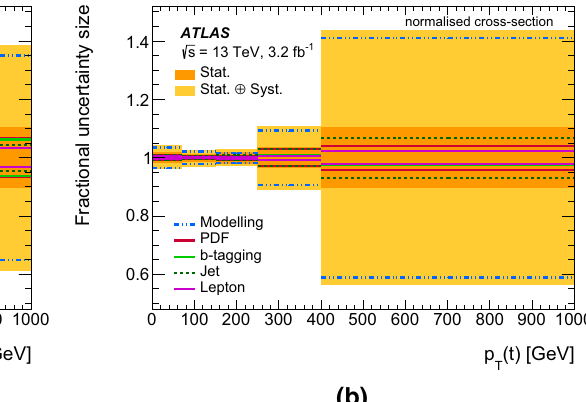
dashed lines . Systematic uncertainties from common sources, such as modelling of the t ¯ t production, have been grouped together. Uncertain- ties due to luminosity or background modelling are not included. The statistical and total uncertainty sizes are indicated by the shaded